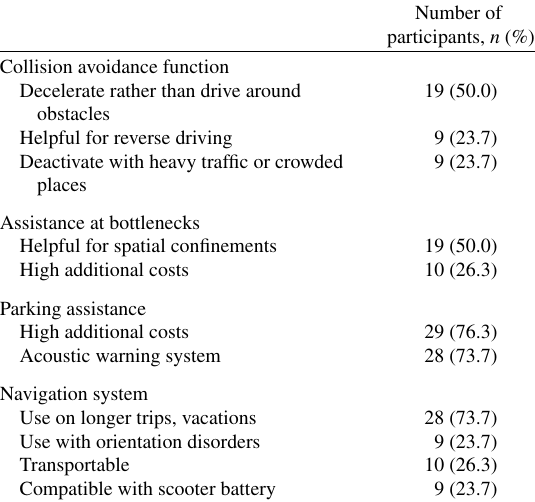
Table 3 Participants’ feedback with regard to the single components of the mobility